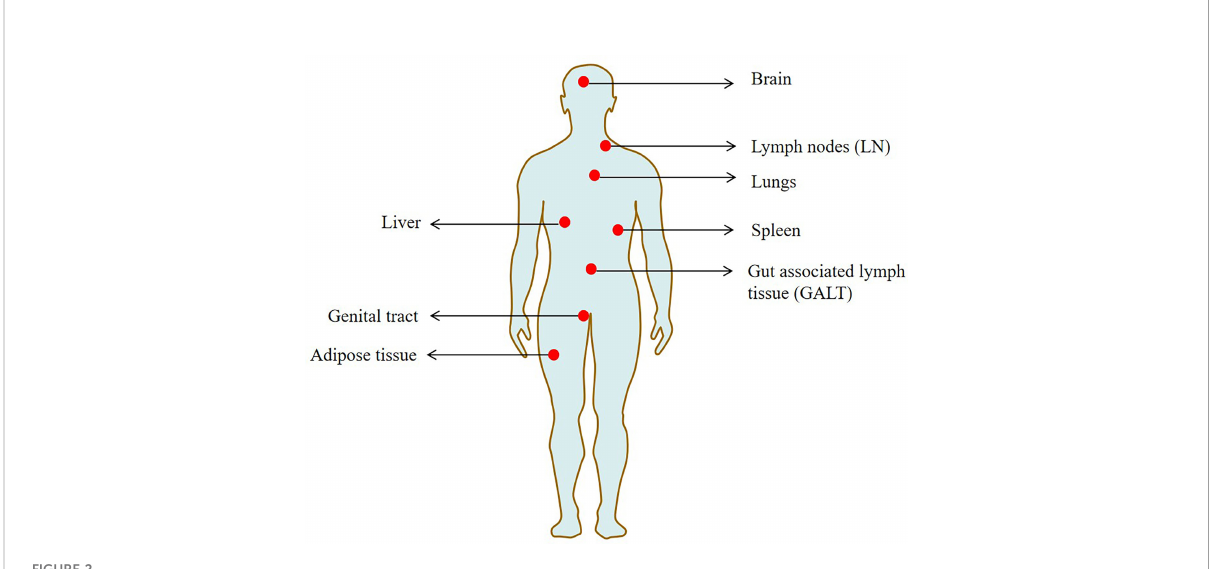
FIGURE 2 The main tissue locations of latent HIV